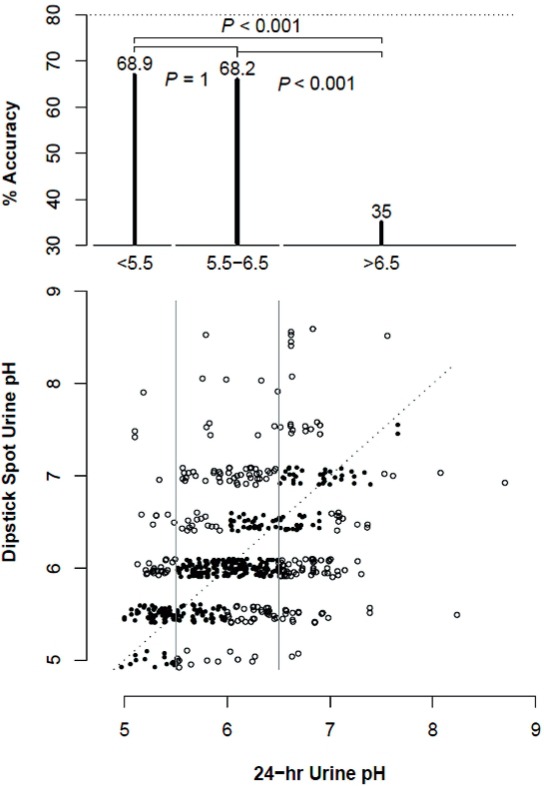
24 hours Urine pH.